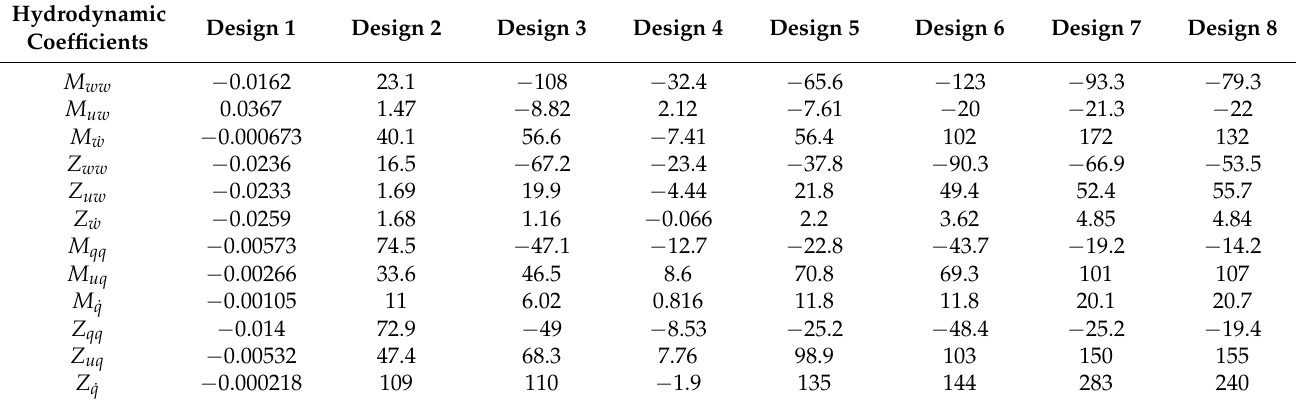
Table 7. Absolute values of non-dimensional hydrodynamic coefficients for Design 1 (Table 4) are presented. Percentage changes of these coefficients with respect to Design 1 for the various design iterations for pure heave and pure pitch are